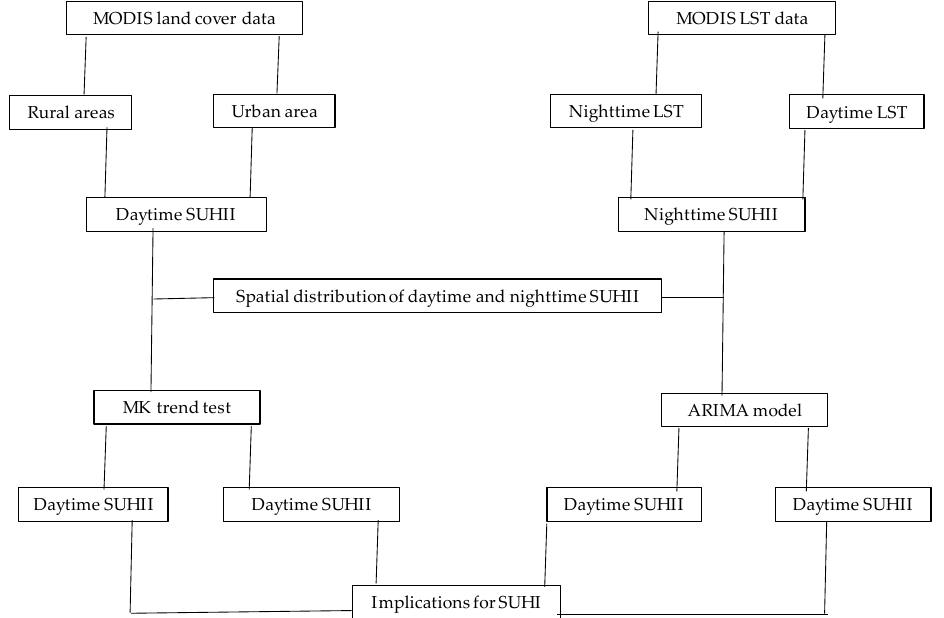
Figure 2. Flow chart for the study .